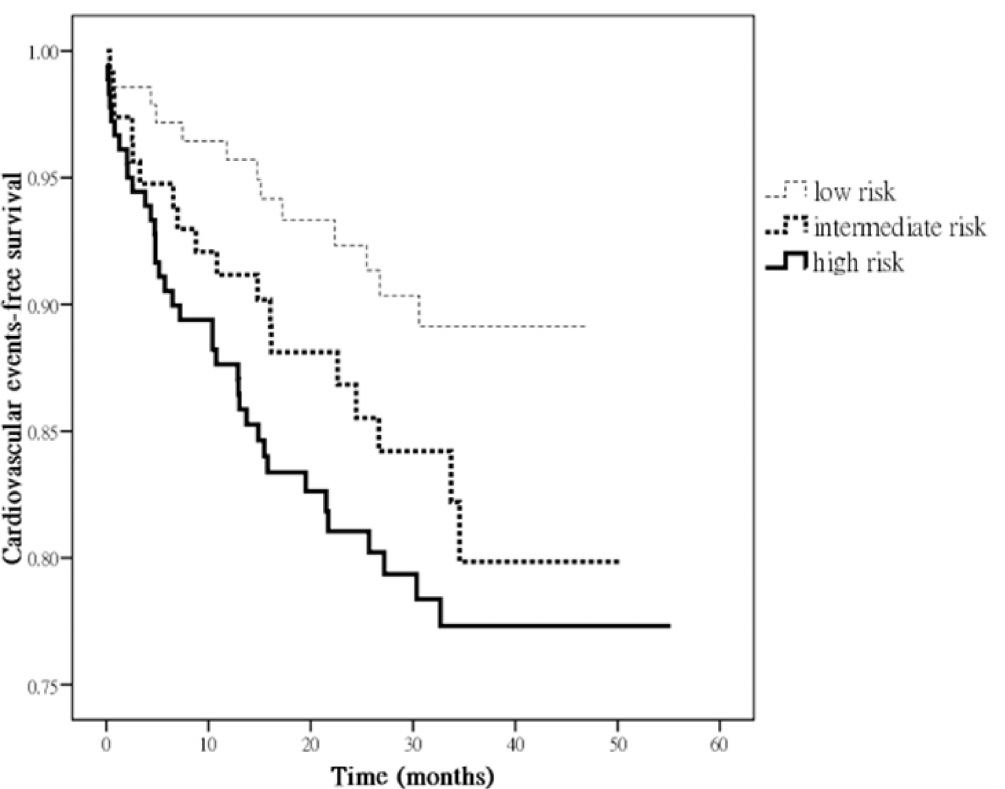
Figure 1. Kaplan-Meier analyses of cardiovascular event-free survival in all patients subdivided according to different FRS category. Patients with ‘‘high’’ risk, but not ‘‘intermediate’’ risk ( vs . ‘‘low’’ risk) were significantly associated with increased cardiovascular event ( P =0.039).